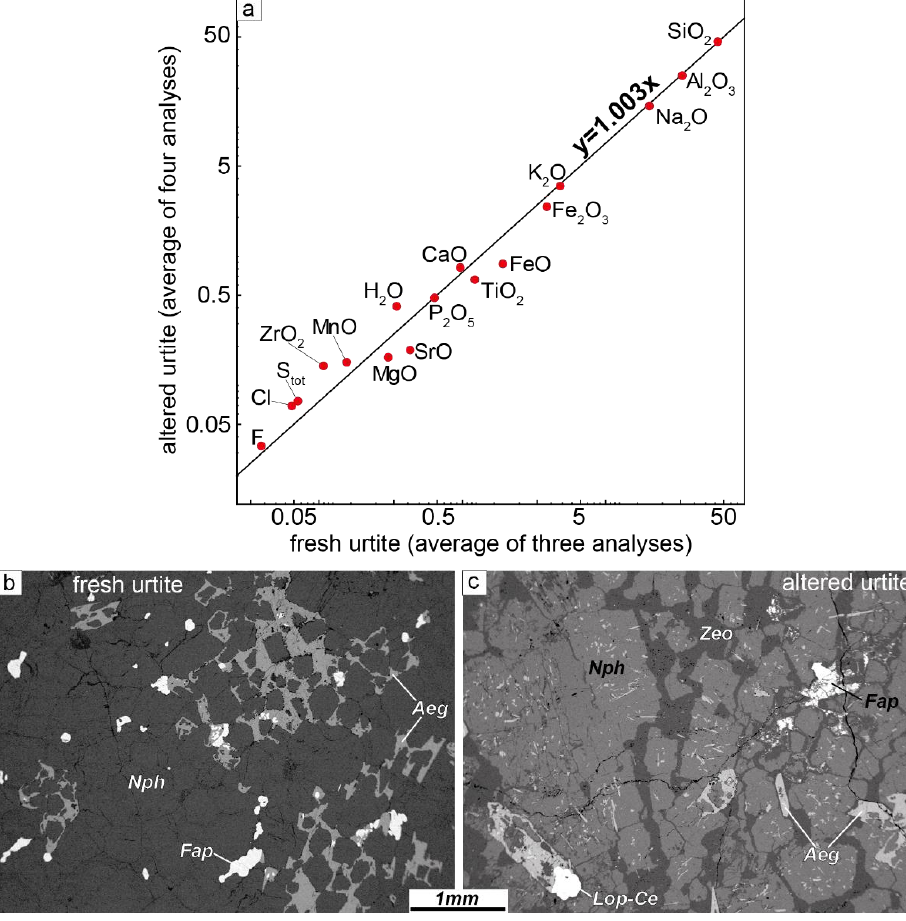
Figure 8. Chemistry of the urtite alteration. ( a ) Isocon diagram comparing the chemistry (in wt.%) of fresh (average of three analyses, Table 8) and altered (average of four analyses, Table 8) urtite from the Layered complex; ( b ) example of fresh urtite (BSE image of sample LV-319/3); secondary alterations of nepheline are not observed; ( c ) example of altered urtite (BSE image of sample LV-335/3); approximately 23% of nepheline is replaced by the natrolite + paranatrolite + nordstrandite aggregate